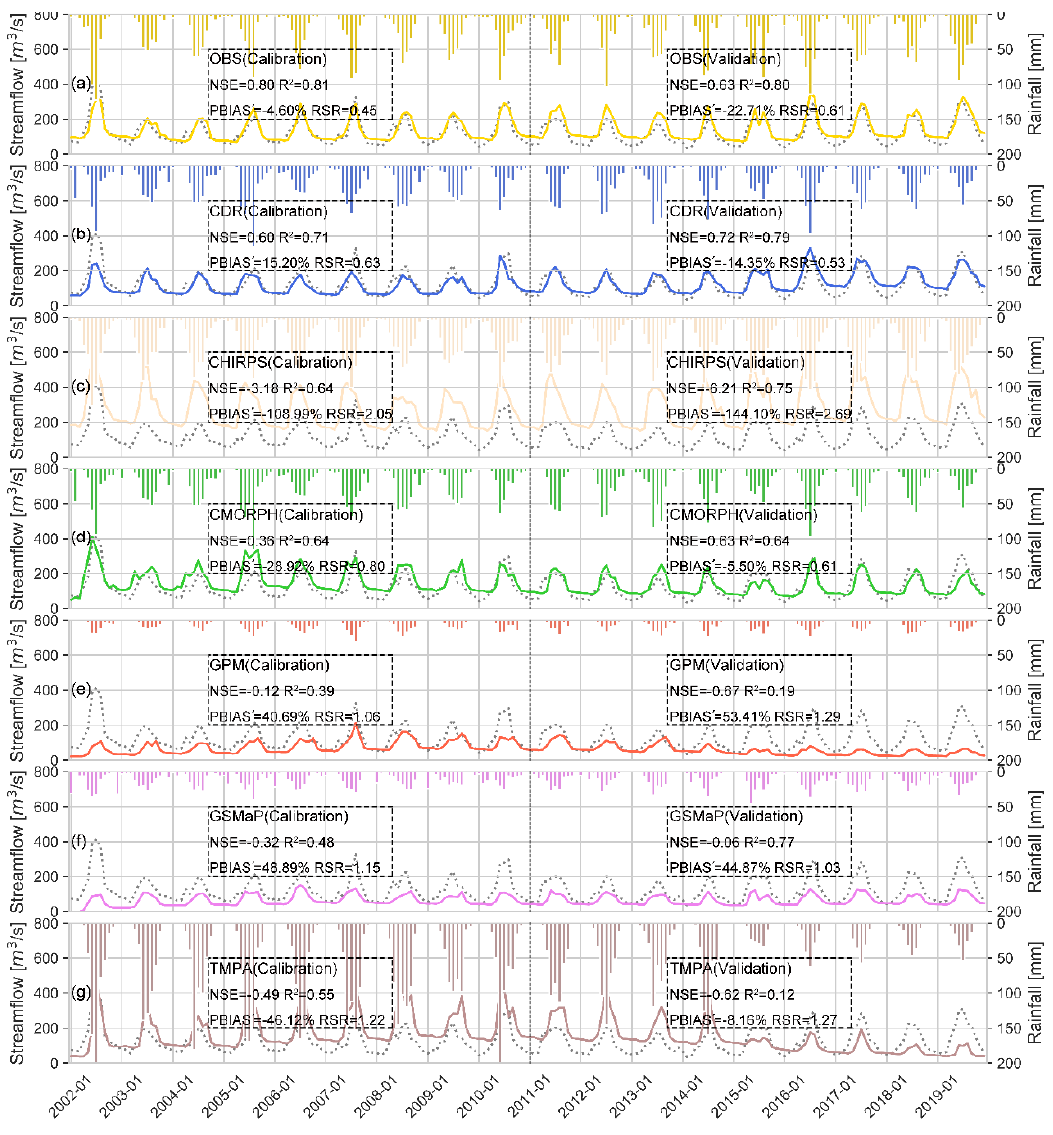
Figure 10. Average monthly precipitation and monthly streamflow simulation results of NW station data and six raw satellite datasets in the calibration period (2002–2010) and the validation period (2011–2019). ( a ) Observed data, ( b ) CDR, ( c ) CHIRPS, ( d ) CMORPH, ( e ) GPM, ( f ) GSMaP, ( g ) TMPA.